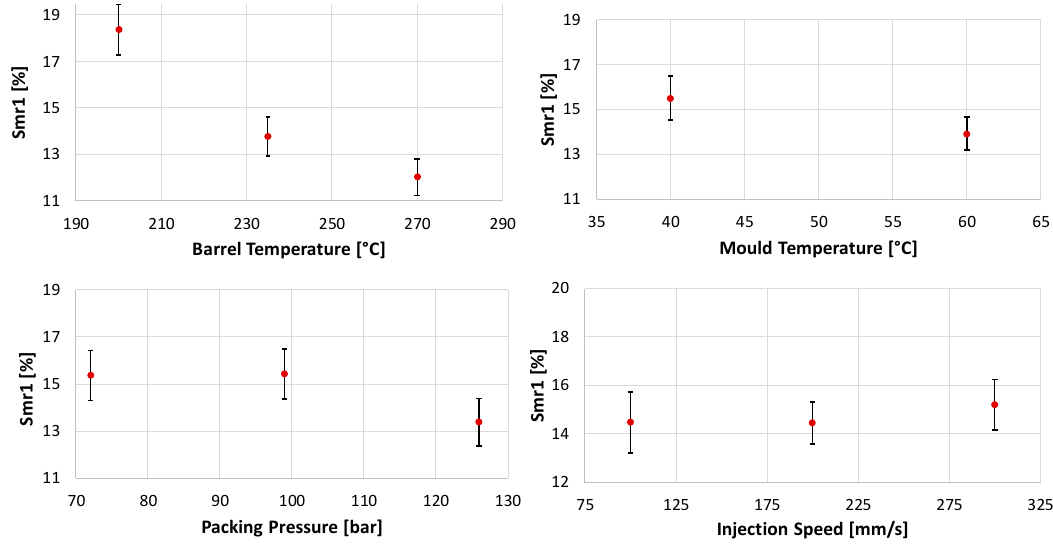
Figure 5. Main Effect of chosen parameters on the roughness parameter Smr1: effects of barrel temperature—T b on Smr1 ( top left ); effects of mould temperature—T m on Smr1 ( top right ); effects of packing pressure—P p on Smr1 ( bottom left ); and effects of injection speed—V i on Smr1 ( bottom right ).